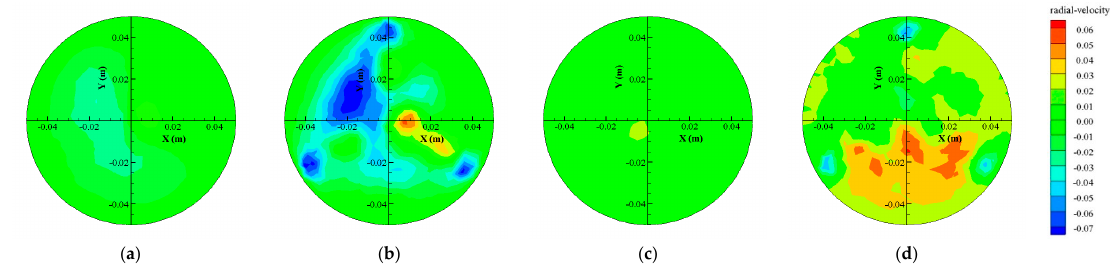
Figure 7. Radial flow velocity distributions of the downstream sections of capsules. ( a ) Z = 0.225 m, L/D = 2; ( b ) Z = 0.075 m, L/D = 2; ( c ) Z = 0.225 m, L/D = 1.67; ( d ) Z = 0.075 m, L/D = 1.67.